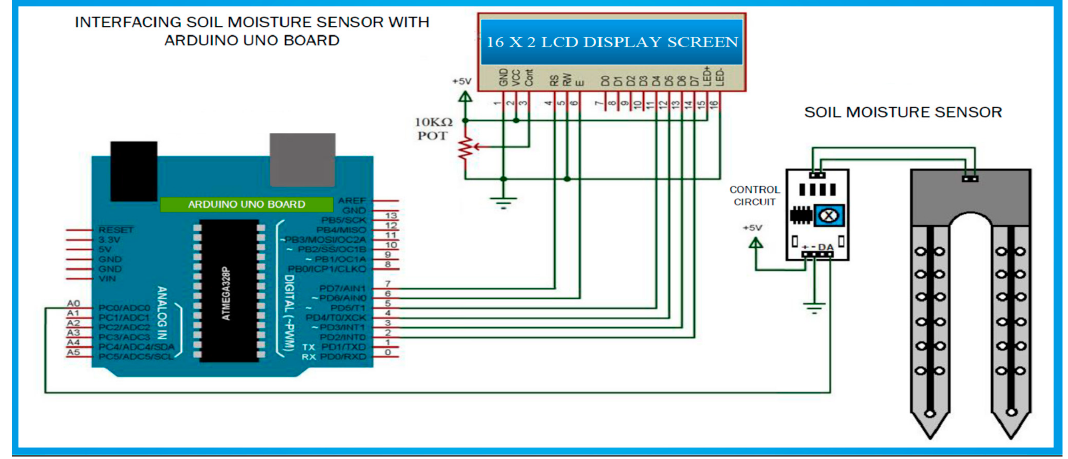
Figure 4. Low-cost sensor interface for smart irrigation modeling and simulation system.